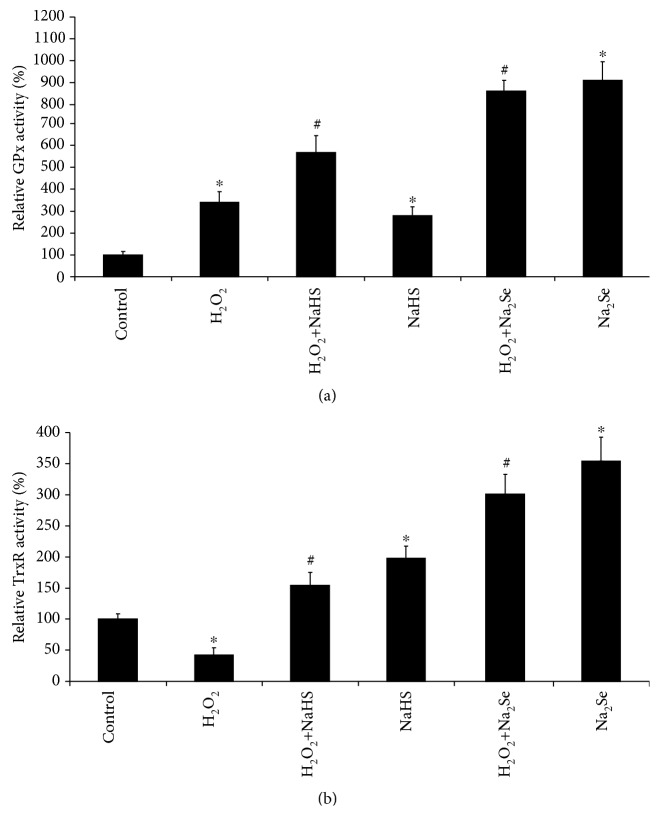
H2S/H2Se induces the activities of GPx and TrxR. H9C2 cells were pretreated with 30 μM NaHS or 0.3 μM Na2Se for 30 minutes, then incubated with 200 μM H2O2 for additional 24 hours followed by measurement of GPx (a) and TrxR (b) activities. ∗p < 0.05 versus control; #p < 0.05 versus H2O2. n = 4. The activity in control cells was considered as 100%.